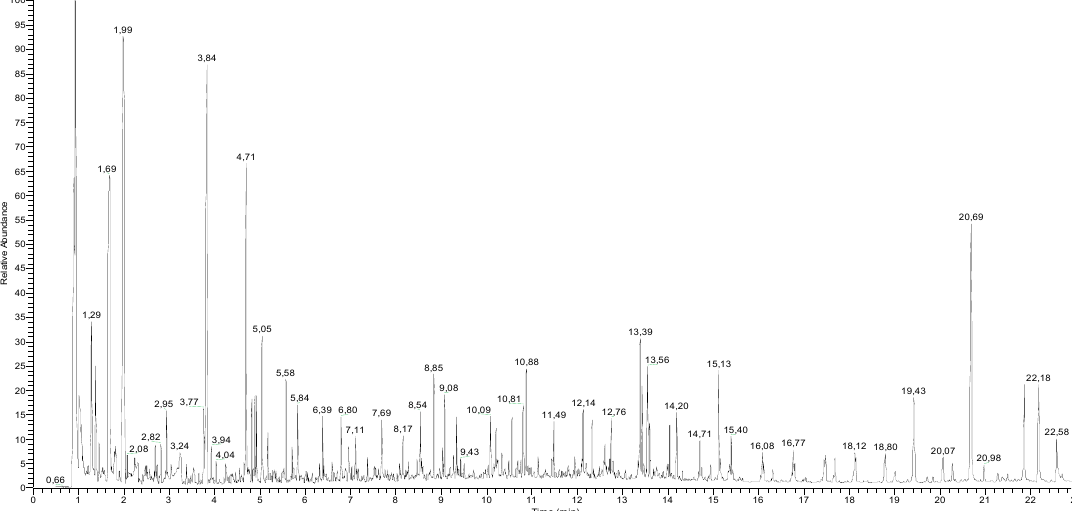
Figure 2. Total ion current pyrogram of Edelwachs after transesterification and Py-GC-MS analysis.